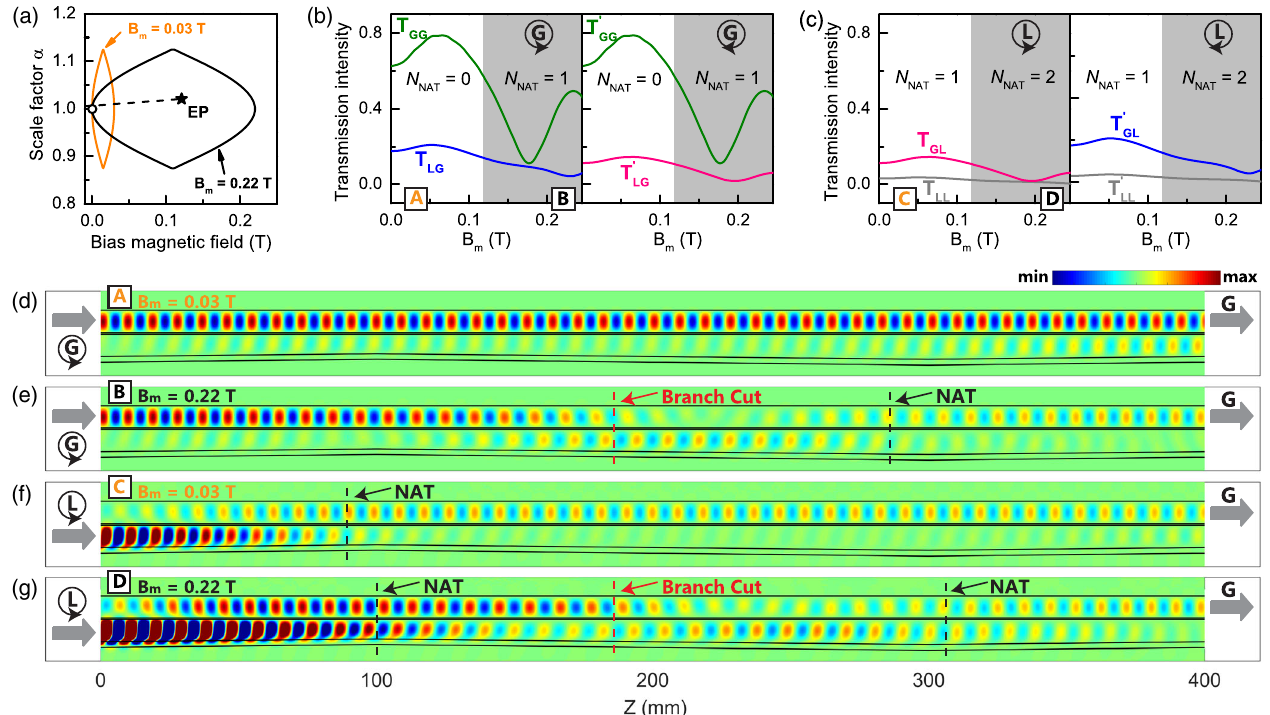
¼ 0 . 03 T (yellow loop not enclosing any EP) and 0.22 T (black loop FIG. 8. (a) Loops in the parameter space generated with B m enclosing one EP). The starting/end point lies at B 0 ¼ 0 and α ¼ 1 , corresponding to the broken phase. The black dashed line represents the broken phase line, where the real parts of the eigenvalues coalesce. (b) Calculated transmission intensities as a function of B for m counterclockwise loops and clockwise loops with a gain mode as the injection. The shaded region represents the area where one EP is dynamically encircled. The number of NATs in the dynamical process is given in different regions. (c) Same as those in (b) except that the injection is a loss mode. (d) – (g) Numerically simulated H field distributions in the waveguide system for configurations A – D (see y text for definition). The black dashed lines and red dashed lines mark the NAT and branch cut, respectively. System parameters are the same as those given in Fig. 7.